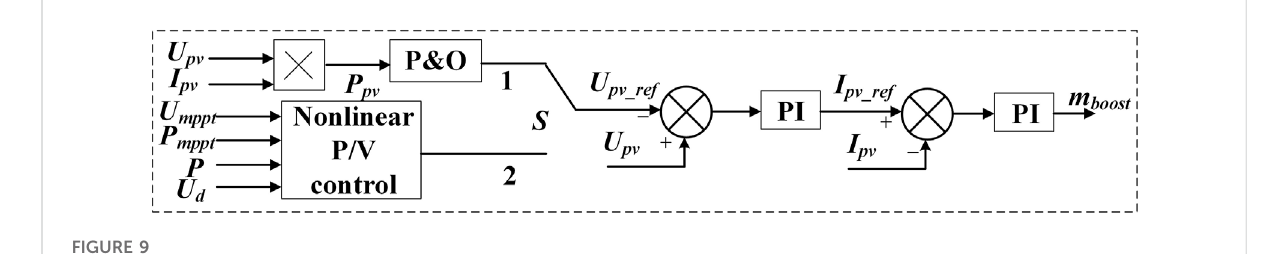
FIGURE 9 The control diagram of the mode switch of